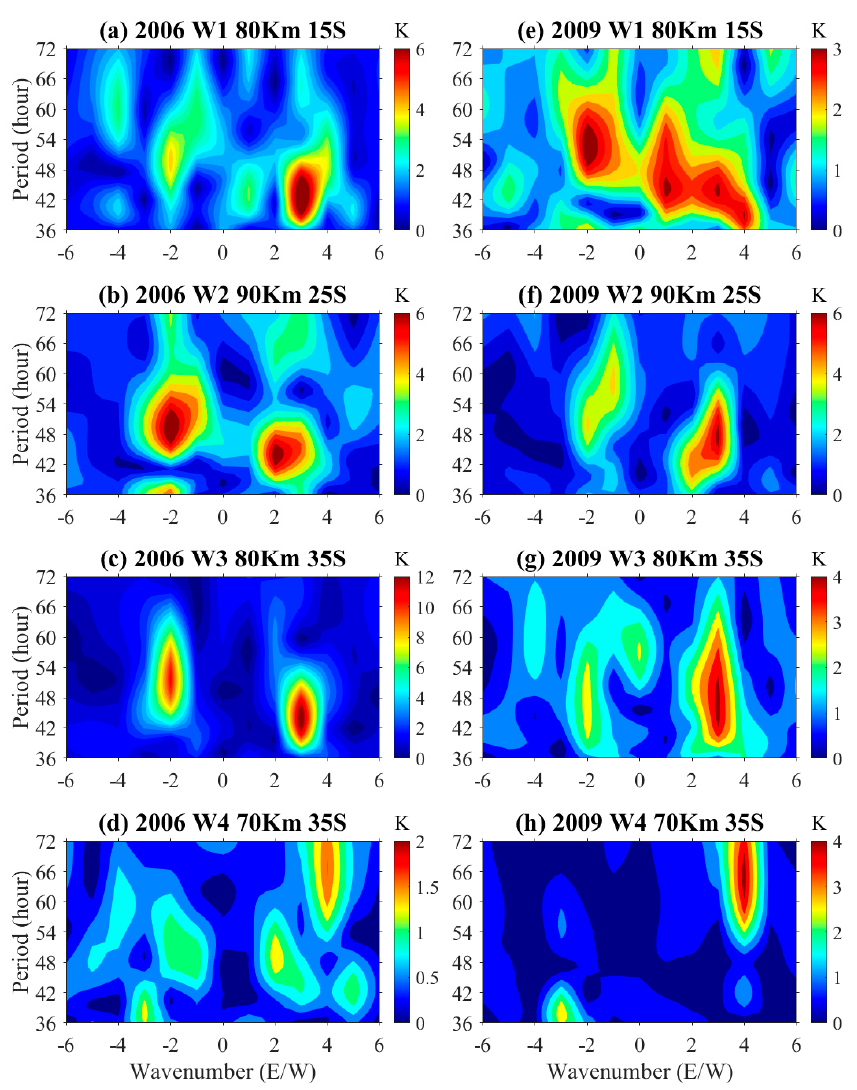
Figure 3. The spectra of the W1, W2, W3, and W4 during 2006 ( a – d ) and 2009 ( e – h ). The temperature spatial structures of W1, W2, W3, and W4 in 2006 and 2009 are shown in the panels of Figure 4, respectively. In the temperature spatial structure of 2006 shown